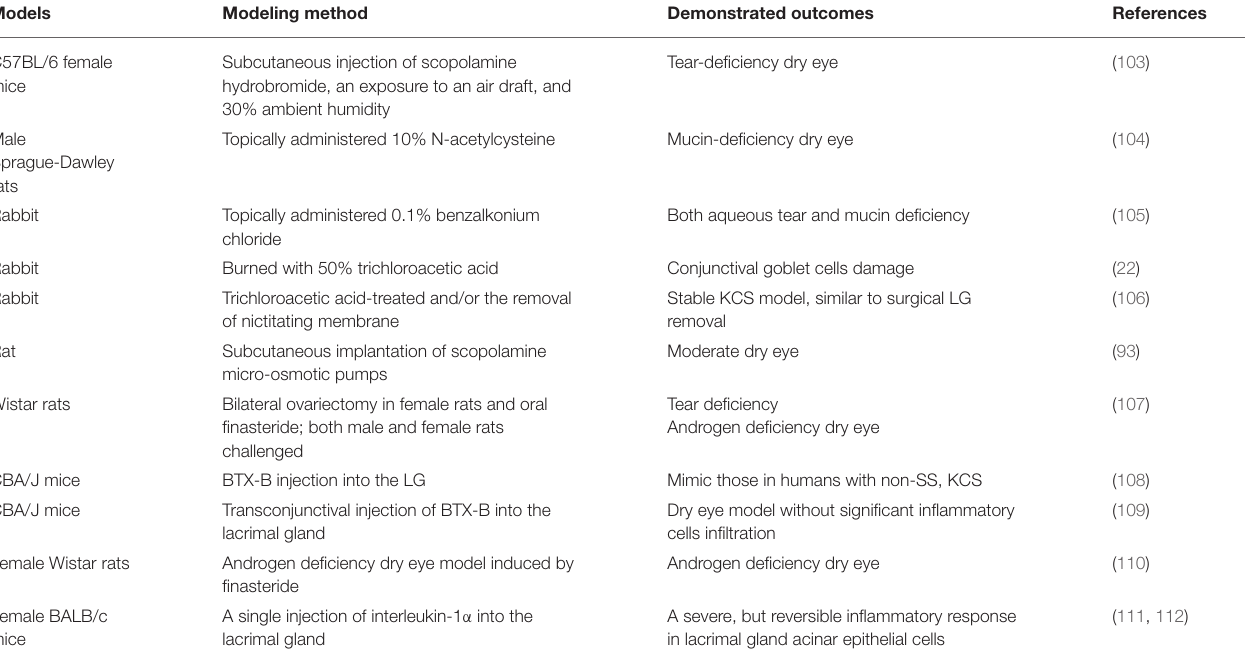
TABLE 3 | A summary of chemical-, biological agent-, and drug-induced dry eye animal